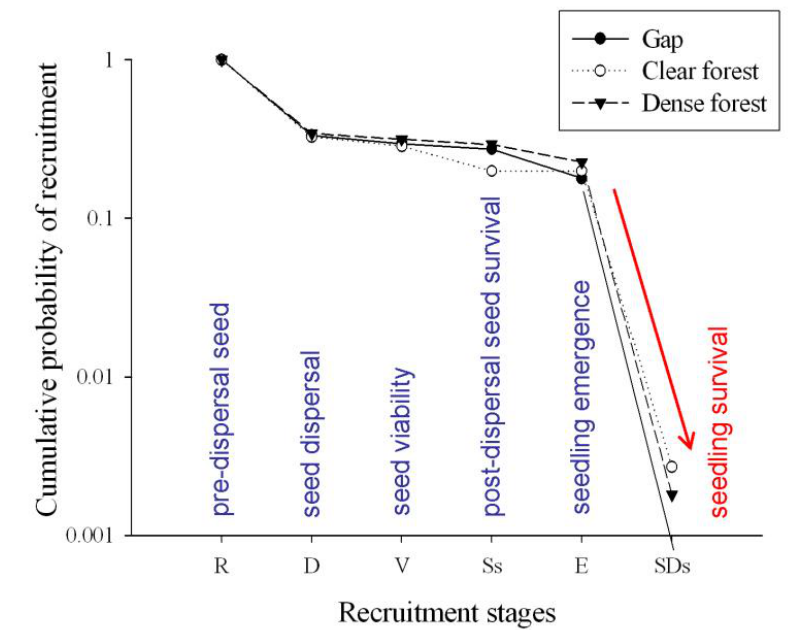
Figure 4. Cumulative probability of recruitment of Pinus nigra throughout the different recruitment stages. R, pre-dispersal seed (arbitrarily assigned the value 1); D = seed = post-dispersal seed survival; E = seedling emergence; dispersal; V = seed viability; S s = seedling SD s